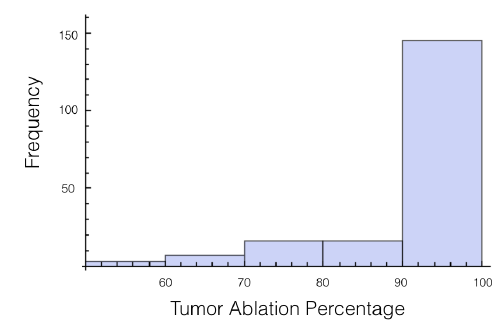
Figure 7. Histogram for percentage of tumor above 700 V/cm for case 3 at 1725 V.